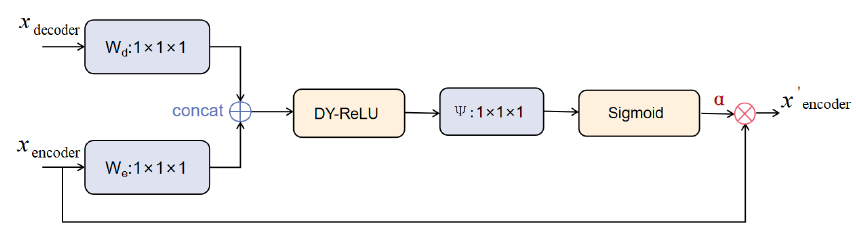
Figure 2. Scheme of the improved attention gate